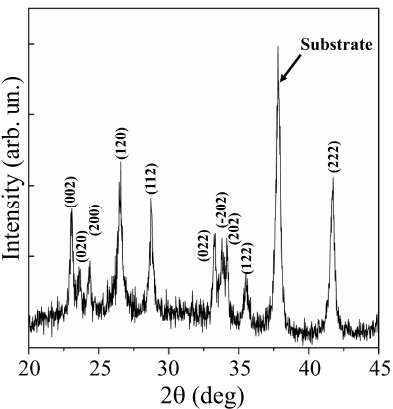
Figure 3. XRD pattern for WO 3 film obtained on an FTO substrate by RPLD at a dry air pressure of 40 Pa.